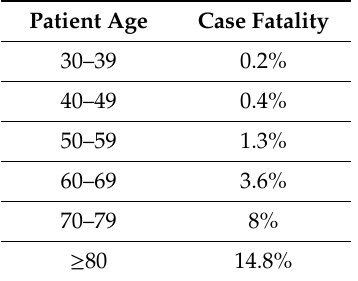
Table 3. Age related case fatalities of COVID-19 [79].